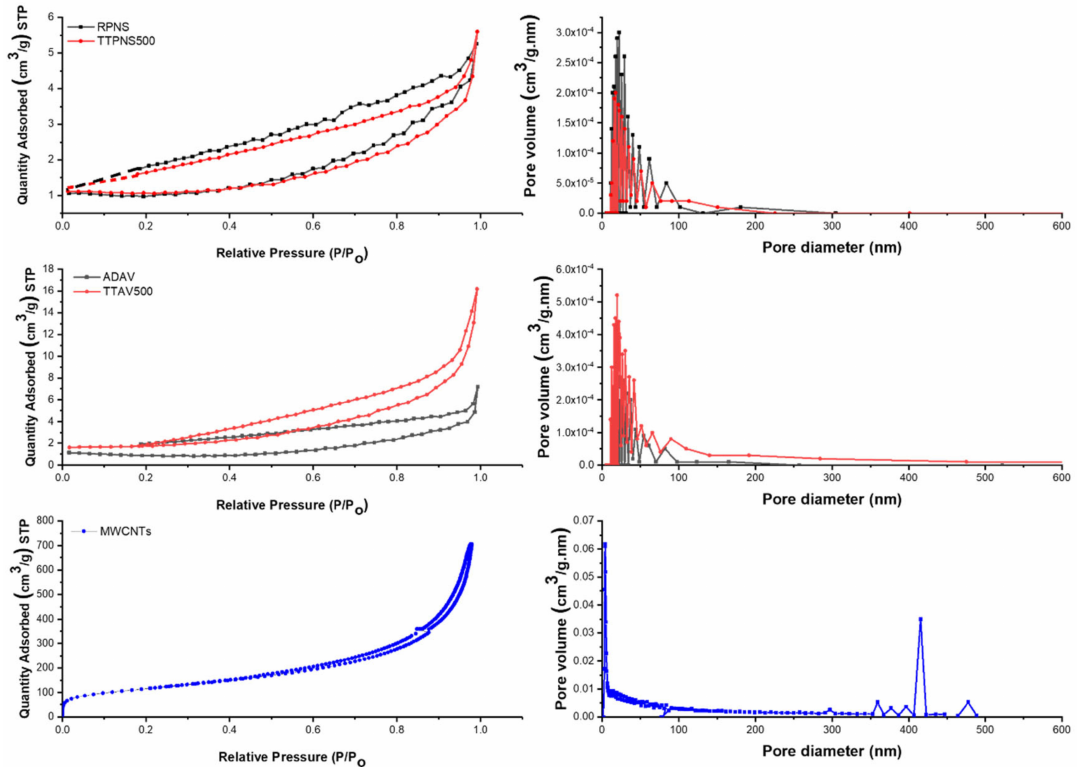
Figure 10. BET analysis of the five